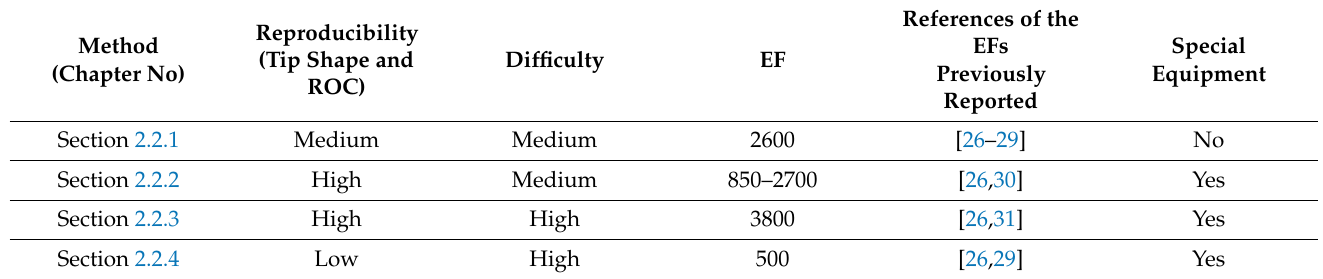
Table 1. The comparison of the methods for the preparation of Au TERS